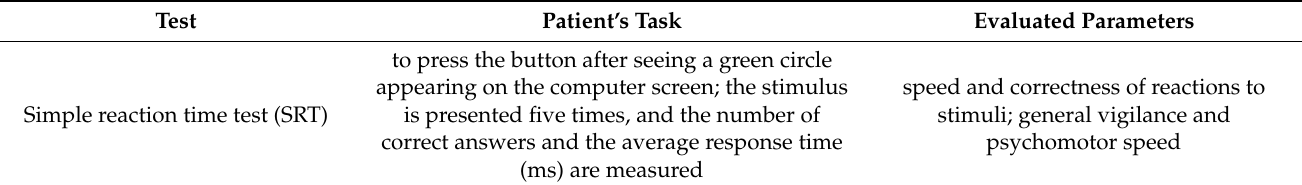
Table 1. The computer-based test battery (Neurotest)